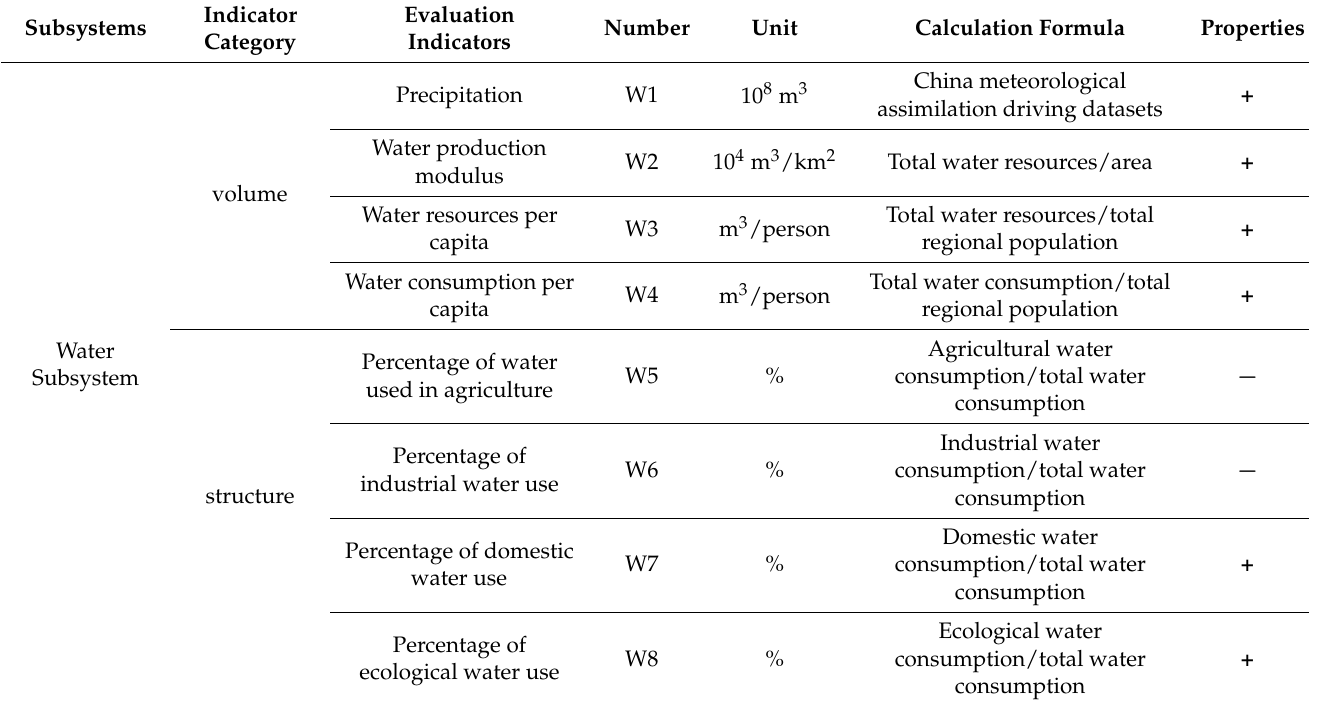
Table 1. Index system of WLF nexus coupling coordination